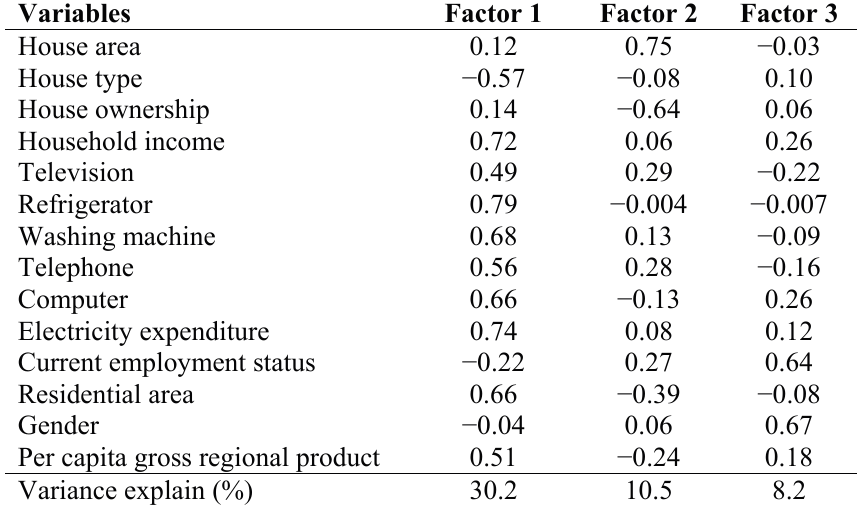
Table 1. Factor-loading matrix for e wealth index patterns by principal component